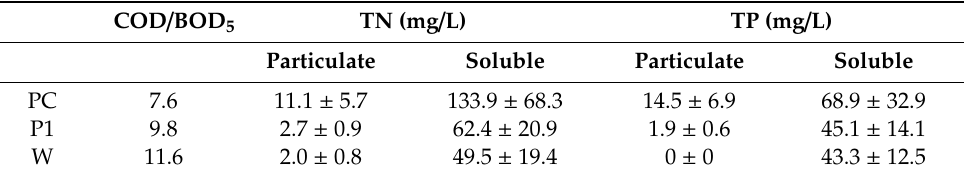
Table 3. COD / BOD 5 ratio and N, P particulate / soluble components across treatment